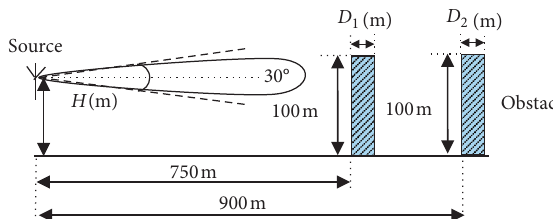
Figure 9: Simulation diagram of double rectangular obstacles.